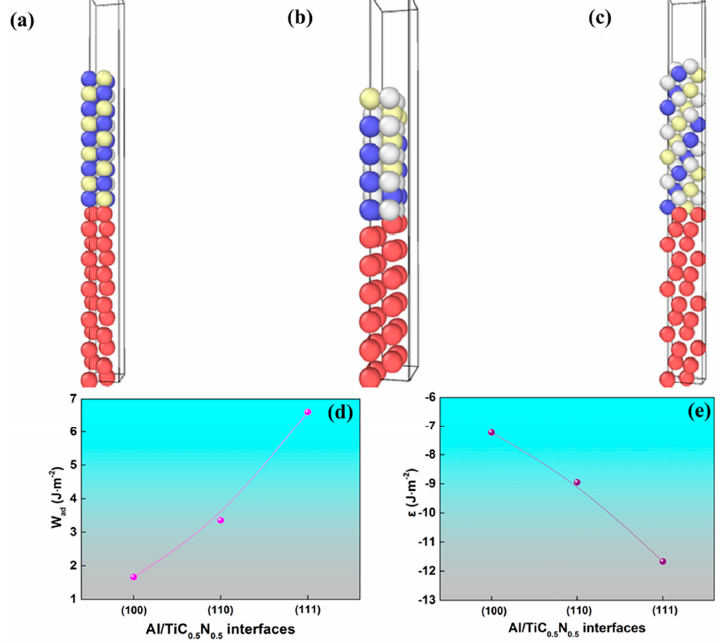
Figure 7. ( a – c ) Supercell models of (100), (110), and (111) Al/TiC 0.5 N 0.5 , respectively; ( d ) work of adhesion of three interface structures; ( e ) interfacial energy of three interface structures. Note that the red, blue, yellow, and white balls in ( a – c ) represent the Al, Ti, C, and N atoms, respectively. Based on the DFT analysis, it can be inferred that of the three Al/TiC 0.5 N 0.5 interfaces, the (111) interface with the largest work of adhesion and smallest interfacial energy is the most thermodynamically stable and energetically favored nucleation site for the hetero- geneous nucleation of α -Al. As a result, it is highly possible that α -Al preferentially nu- cleates on the most close-packed plane of TiC 0.5 N 0.5 , i.e., (111) TiCN . The experimental results together with the DFT analysis provide the robust evidence that TiC 0.5 N 0.5 can act as a potent nucleant for the α -Al grain to promote the grain refinement of α -Al. It is noted that although NPs can be captured by the advancing solid/liquid interface at enhanced cooling conditions and thus distributed intragranularly throughout the ma- trix, they cannot be responsible for α -Al nucleation. In light of the classic nucleation the- ory, each nucleation site corresponds to one grain. As a result, merely a minority of NPs can participate in the nucleation events. Furthermore, the size of NPs and their size dis- tribution have a significant influence on the nucleation efficiency. Based on the free growth theory [9], for a given particle size, the critical undercooling for grain initiation on the particle is fixed, above which the nuclei can continue to grow and below which the free growth of the crystal is stifled. At enhanced cooling conditions, the melt undercooling may be large enough to activate NPs as potent nucleants for the heterogeneous nucleation of α -Al, generating a high nucleation rate. However, a large undercooling can also pro- mote the grain growth, which in turn gives a coarse grain size [17]. In fact, the nucleation of new crystals competes with the growth of nucleated grains [7,9,37]. The results of this